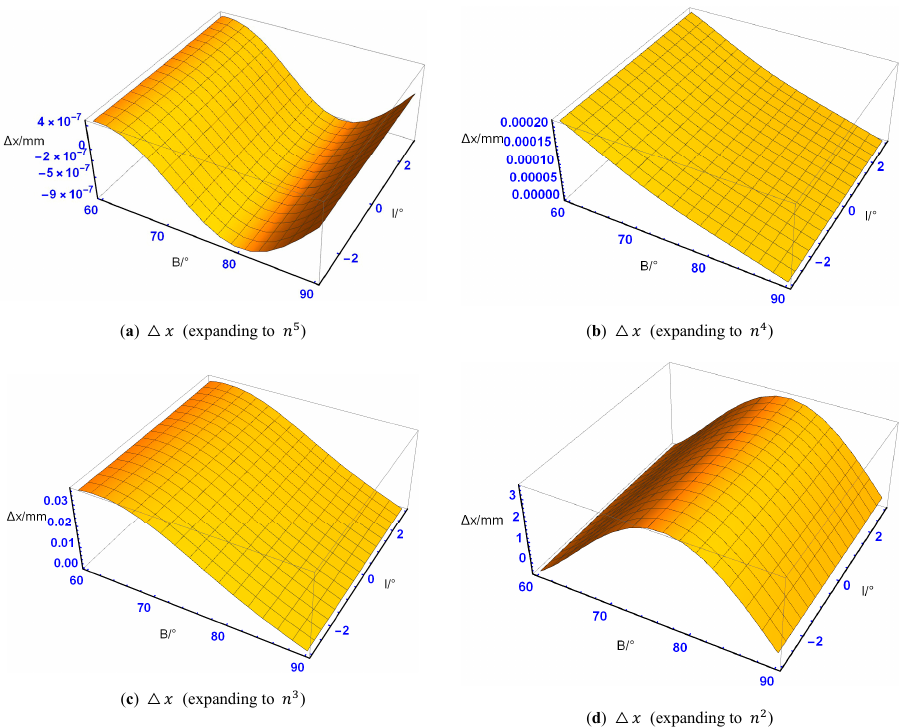
Figure 6. The distribution of the abscissa truncation difference ∆ x when expanding to n 5 , n 4 , n 3 , and n 2 .